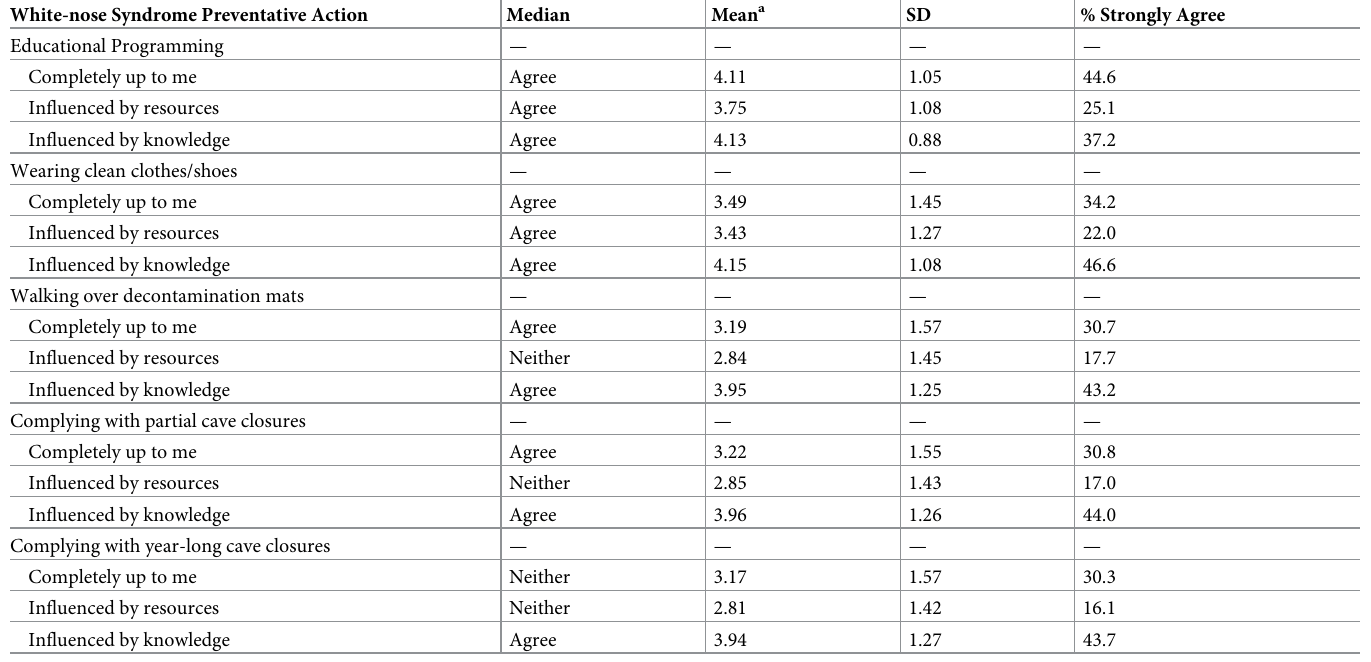
Table 4. Visitor perceived behavioral control responses to the statement “Whether or not I participate/comply with [WNS preventative action] is [completely up to me, influenced by my resources, influenced by my awareness],”